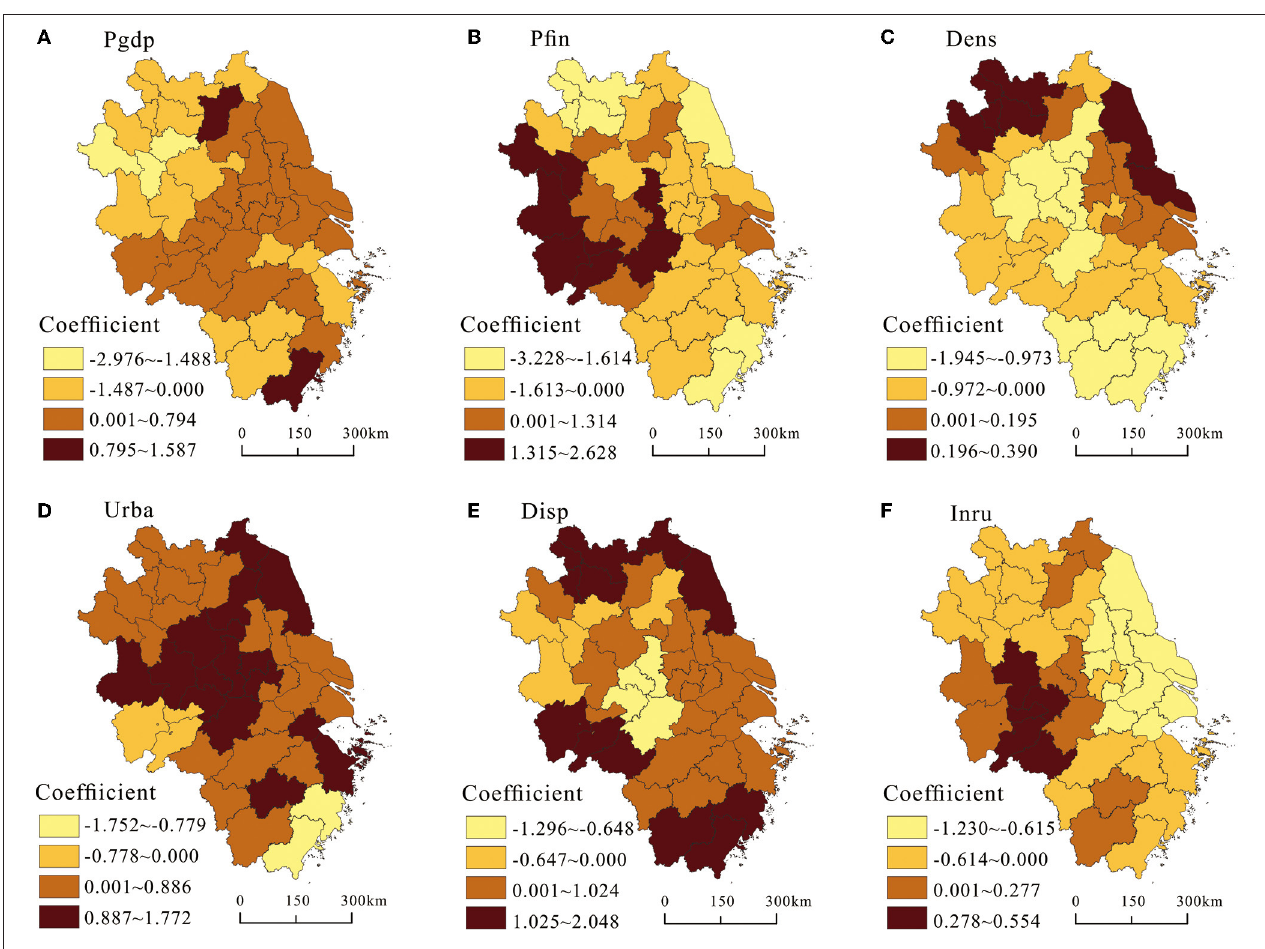
FIGURE 7 | Spatial heterogenous effects of different variables on the supply level of healthcare